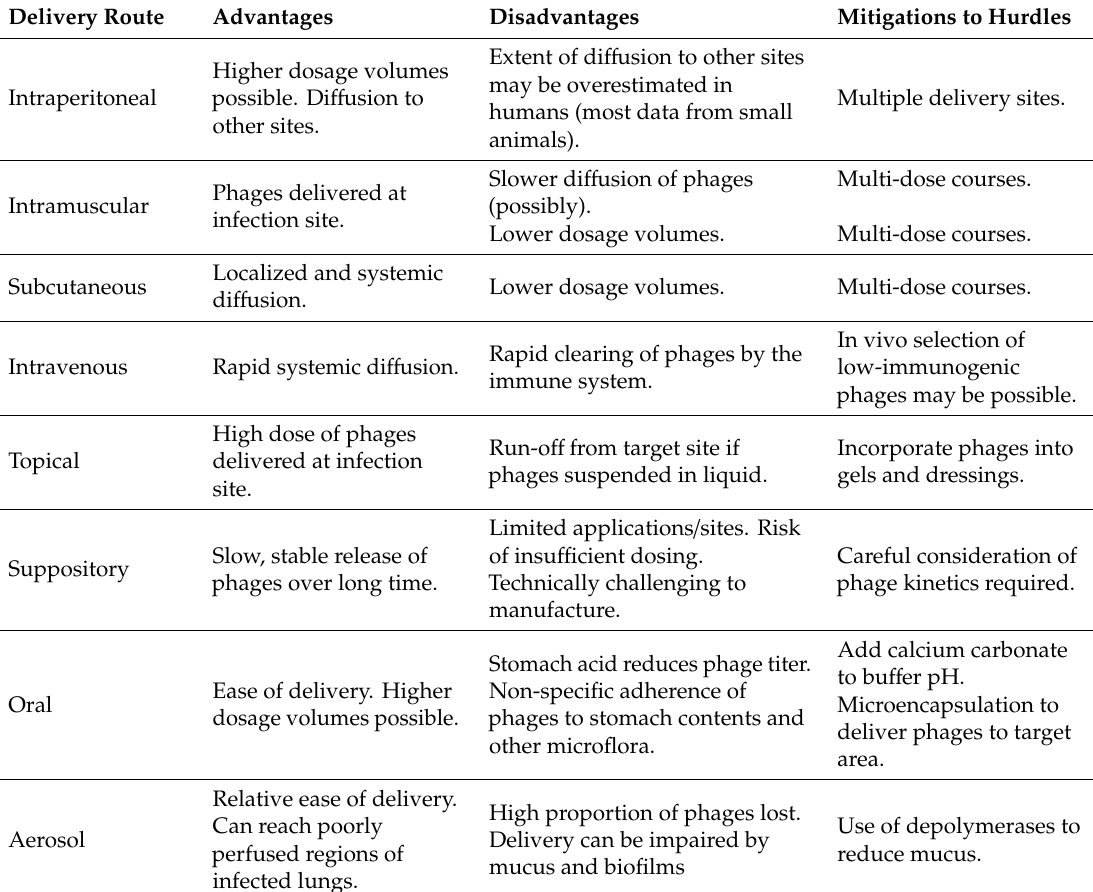
Table 1. Routes of administration for phage